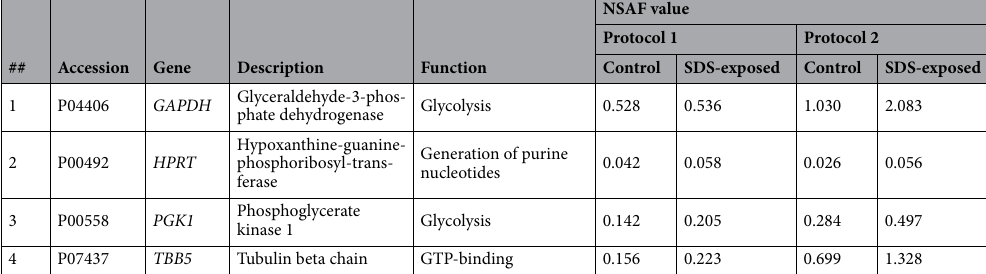
Table 1. Housekeeping proteins identified in HaCaT keratinocytes. Protocol 1—0.2% SDS lysis with 1DE-gel concentration approach; Protocol 2—osmotic shock (H 2 O-based)